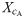
Relationships of cranio-caudal/medio-lateral navicular displacements (NCC/NML) to hindfoot to tibia (HFtoTBA) and global hindfoot (HFL) rotations.(a) Averages among participants with standard deviations for HFtoTBA internal/external rotation and inversion/eversion and for HFL inversion/eversion during the stance phase (SP). Corresponding ranges of motion are given in Table 2. The blue parts represent the absorption and the red parts the generation phases. (b), (e) Displacement-displacement diagrams of mean HFtoTBA and mean HFL rotations versus mean NCC and mean NML with median cross-correlation coefficients for the whole stance phase (Xc), the absorption phase (XcA) and the generation phase (XcG) in the titles. (c), (f) Scatter plots of cross-correlation coefficients for the whole stance phase (Tot), the absorption phase (Abs) and the generation phase (Gen) from all participants for the relationships presented in rows 2 and 4. Large markers represent the medians. (d), (g) Distribution of the cross-correlation coefficients among the strong, moderate and weak classes (values given in Table 3).